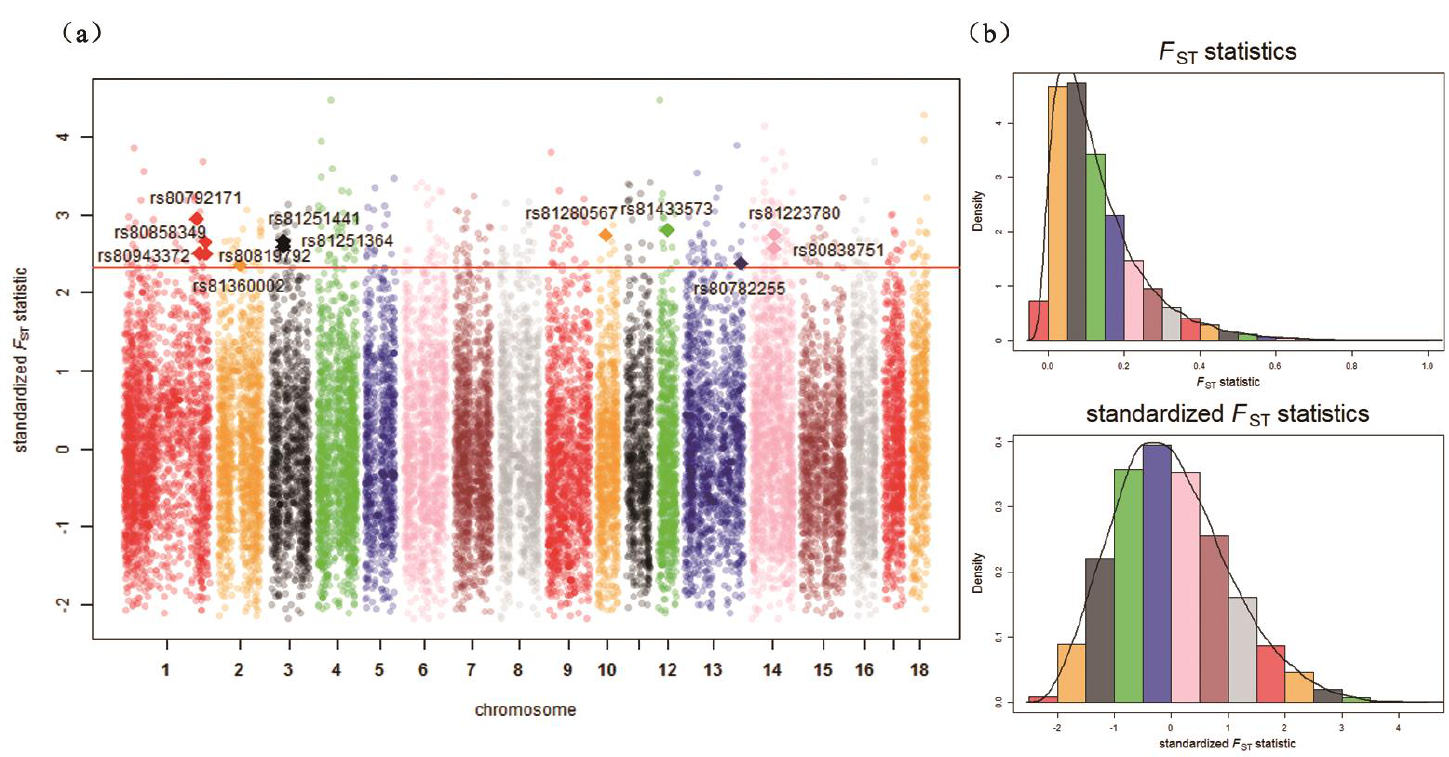
Figure 6. F ST statistics across all autosomes in the Ding’an and Tunchang / Saba groups. ( a ) Genome-wide distribution of signatures of selection detected by F ST statistics across all autosomes in the Ding’an and Tunchang / Saba groups. The SNPs shown as diamonds are the significant SNPs detected simultaneously by two methods. The red line shows the threshold p -value (0.01). ( b ) The distribution of unstandardized F ST statistics and standardized F ST statistics across all autosomes in the Ding’an and Tunchang / Saba